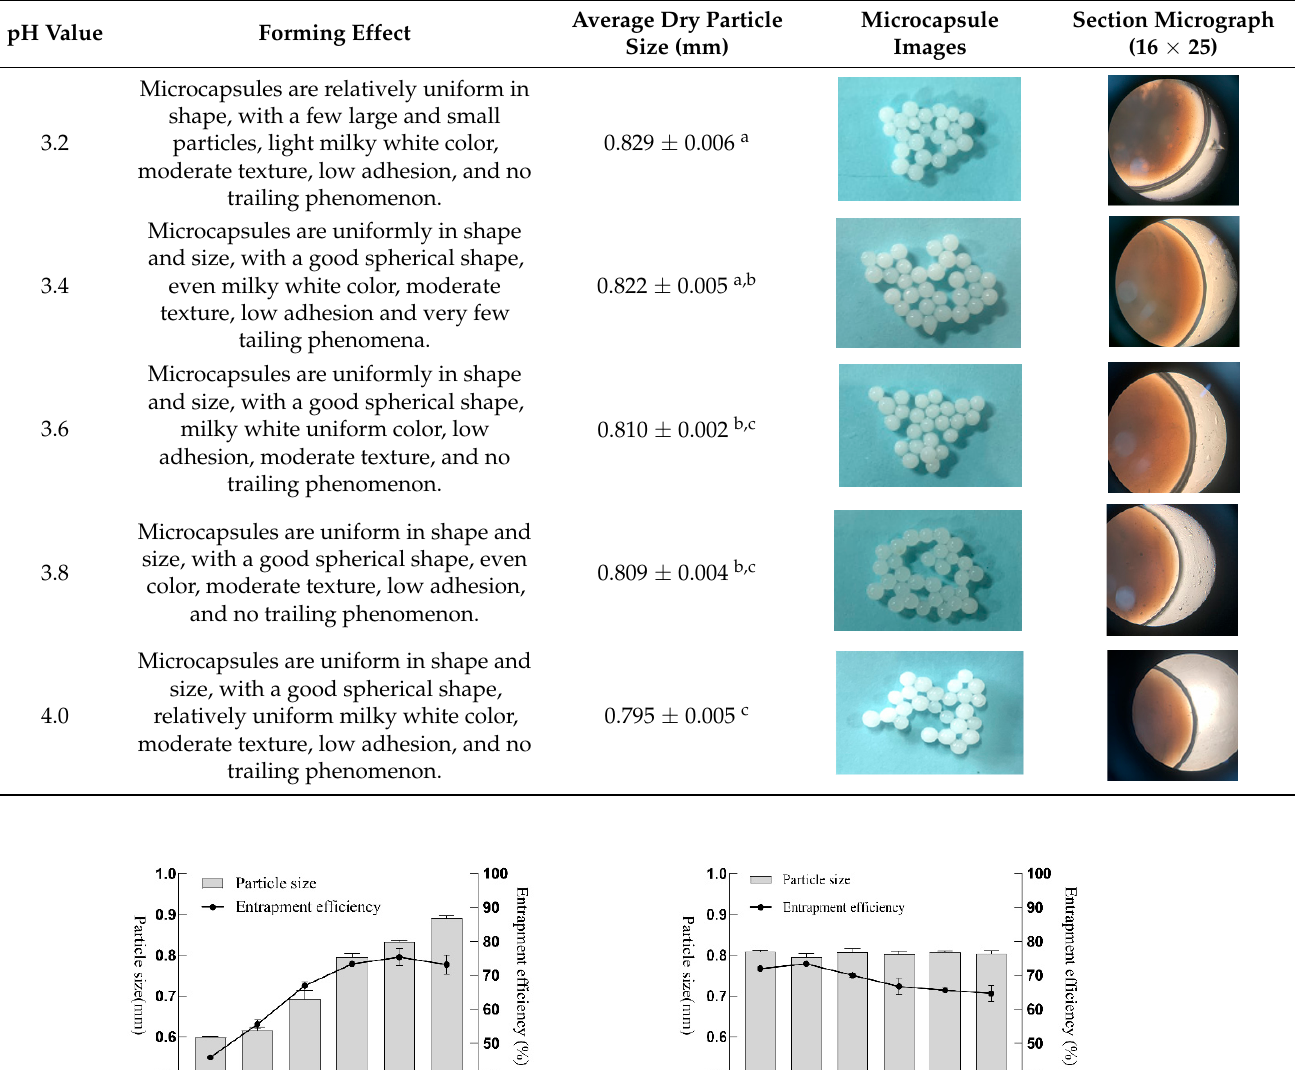
Table 5. Effect of pH value on microcapsule formation.